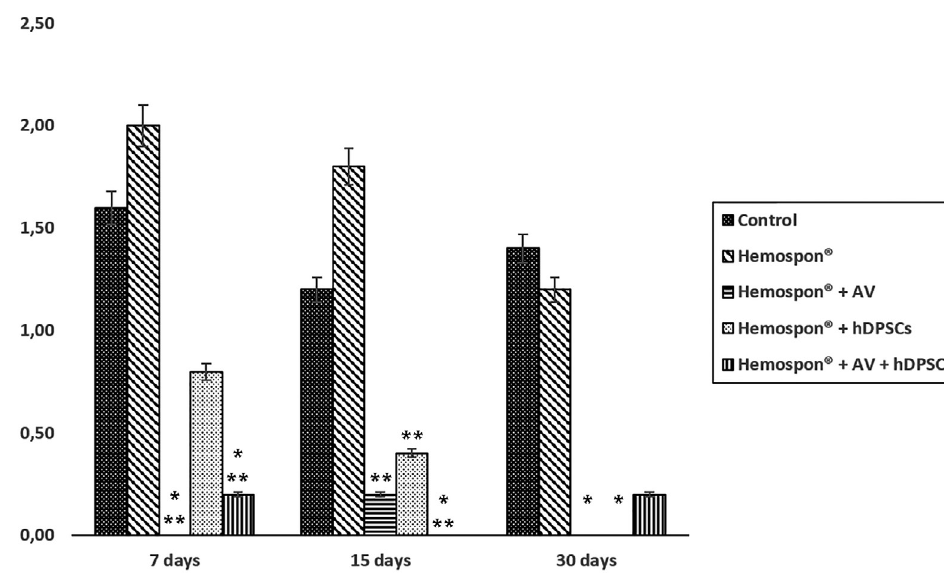
Figure 5- Average scores for the experimental groups’ acute inflammatory infiltrate at each evaluated time